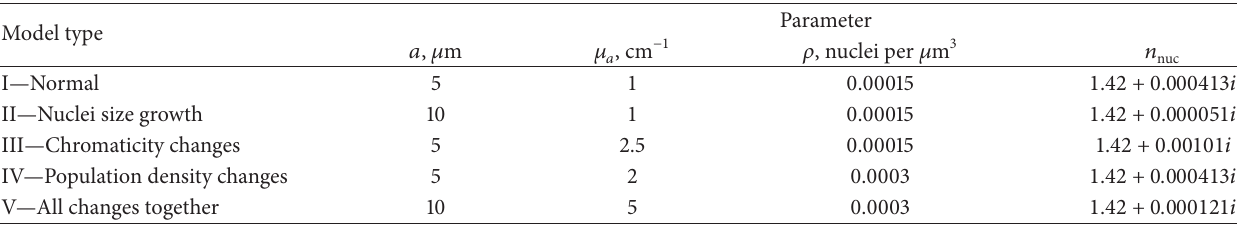
Table 1: Input parameters applied for electro-magnetic theory-based calculations performed on each of the 5 types of bladder epithelial tissue-like